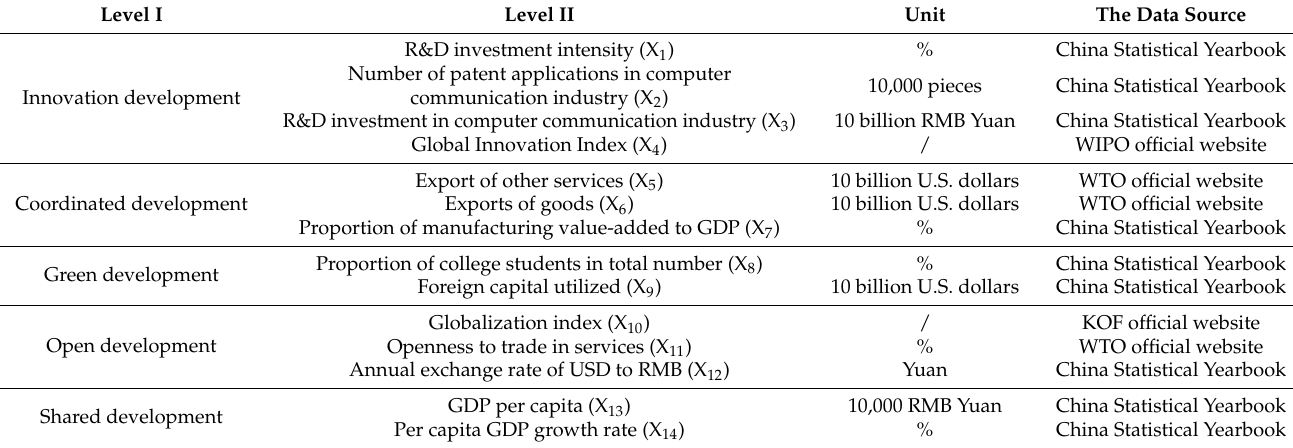
Table 1. Evaluation system of influencing factors of international